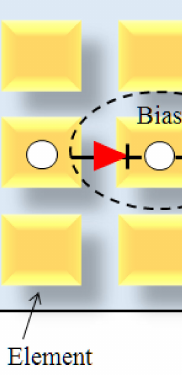
Figure 5. EM reflection via PIN